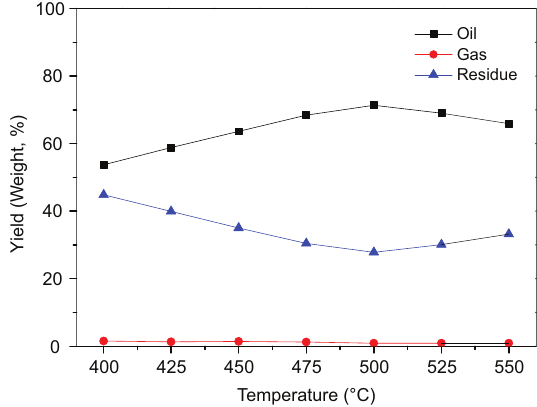
Figure 4. Distribution of pyrolysis products at varied